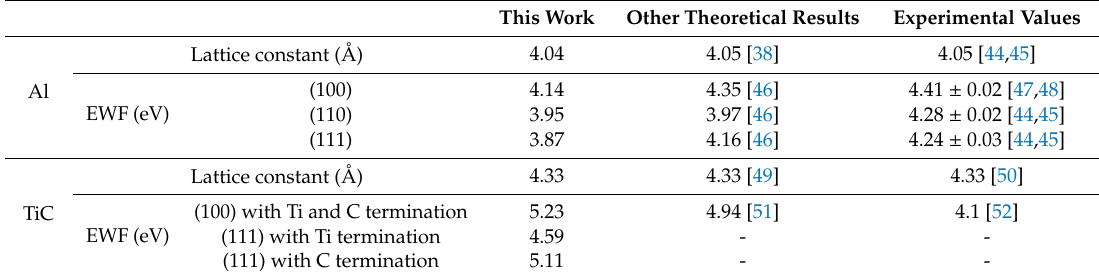
Table 3. Lattice constants and electron work functions of Al and TiC. This Work Other Theoretical